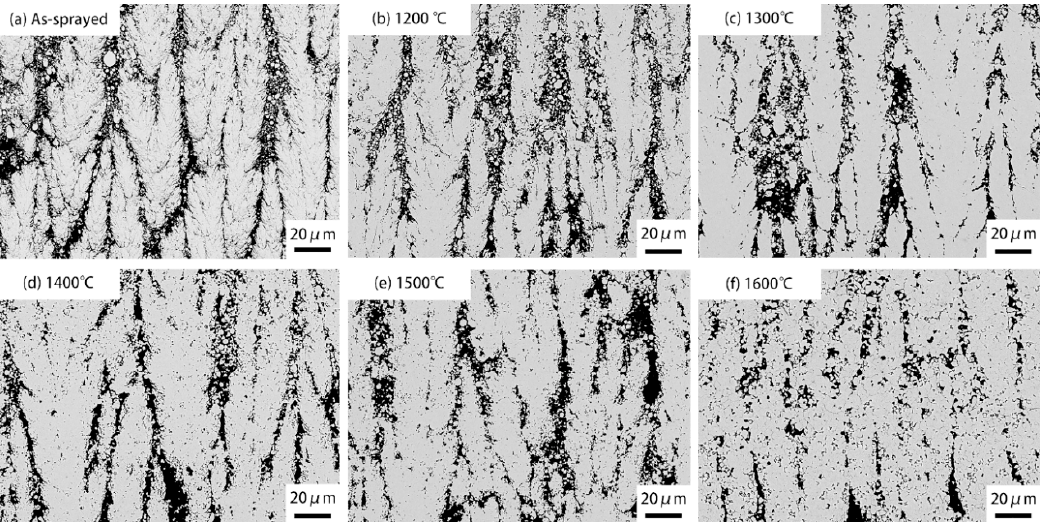
Figure 5. SEM micrographs of polished cross-sections of PS–PVD coatings as a function of temperature: ( a ) as-sprayed; ( b ) 1200 °C; ( c ) 1300 °C; ( d ) 1400 °C; ( e ) 1500 °C; and ( f ) 1600 °C.